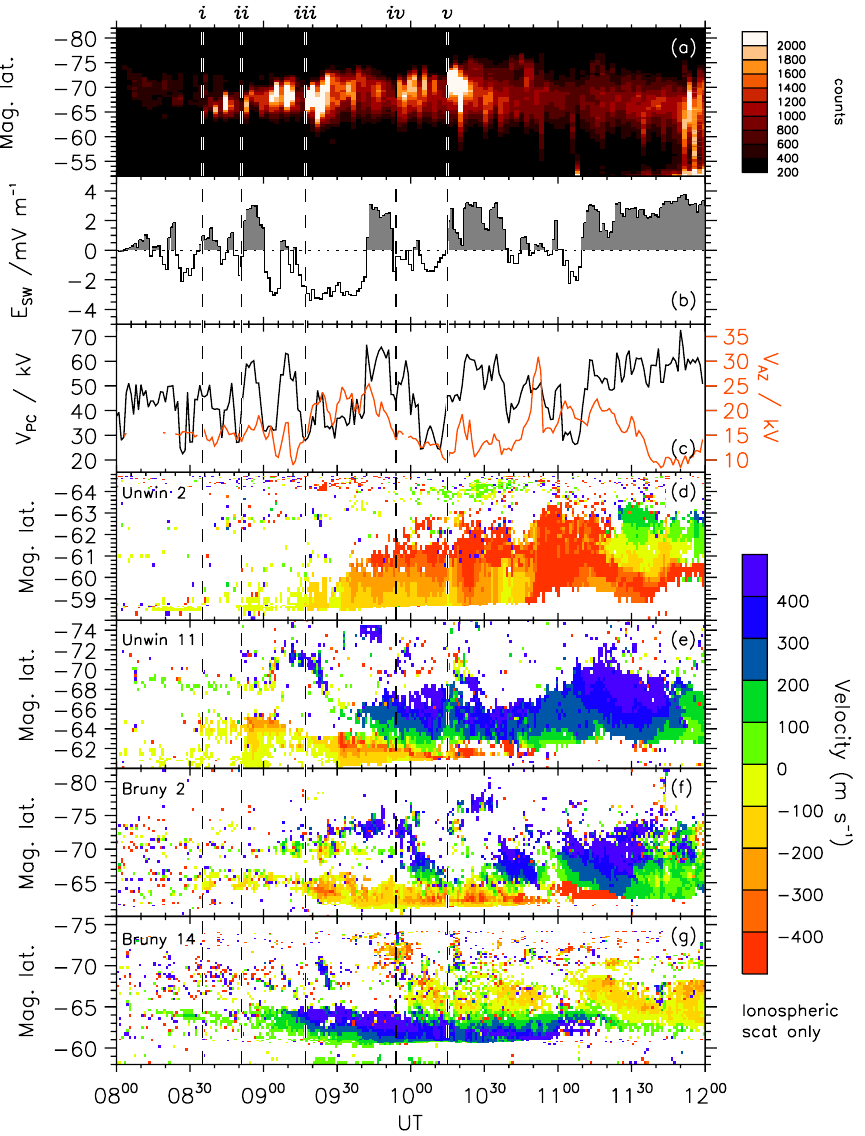
Fig. 3. (a) The keogram of IMAGE data from Fig. 2. (b) The solar wind electric field, E SW , which has been determined from the ACE upstream interplanetary data (and lagged by 45min to account for the propagation delay between the spacecraft and the dayside ionosphere). (c) Electric potential information from the Map Potential analysis. The black curve is the total transpolar voltage determined from the peaks in the potential from the analysis and the red curve is the voltage across the 21:00 MLT auroral zone ( × 2, for clarity, such that the scale for this curve is actually 10–35kV). (d–g) Time-series line-of-sight velocity data from the four radar beams illustrated in Fig. 1, colour-coded according to the bar on the right. The vertical dashed lines are as in Fig.